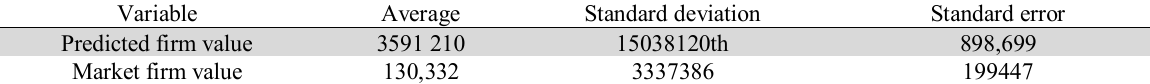
Statistical indicators of predicted firm values and market values Variable Average